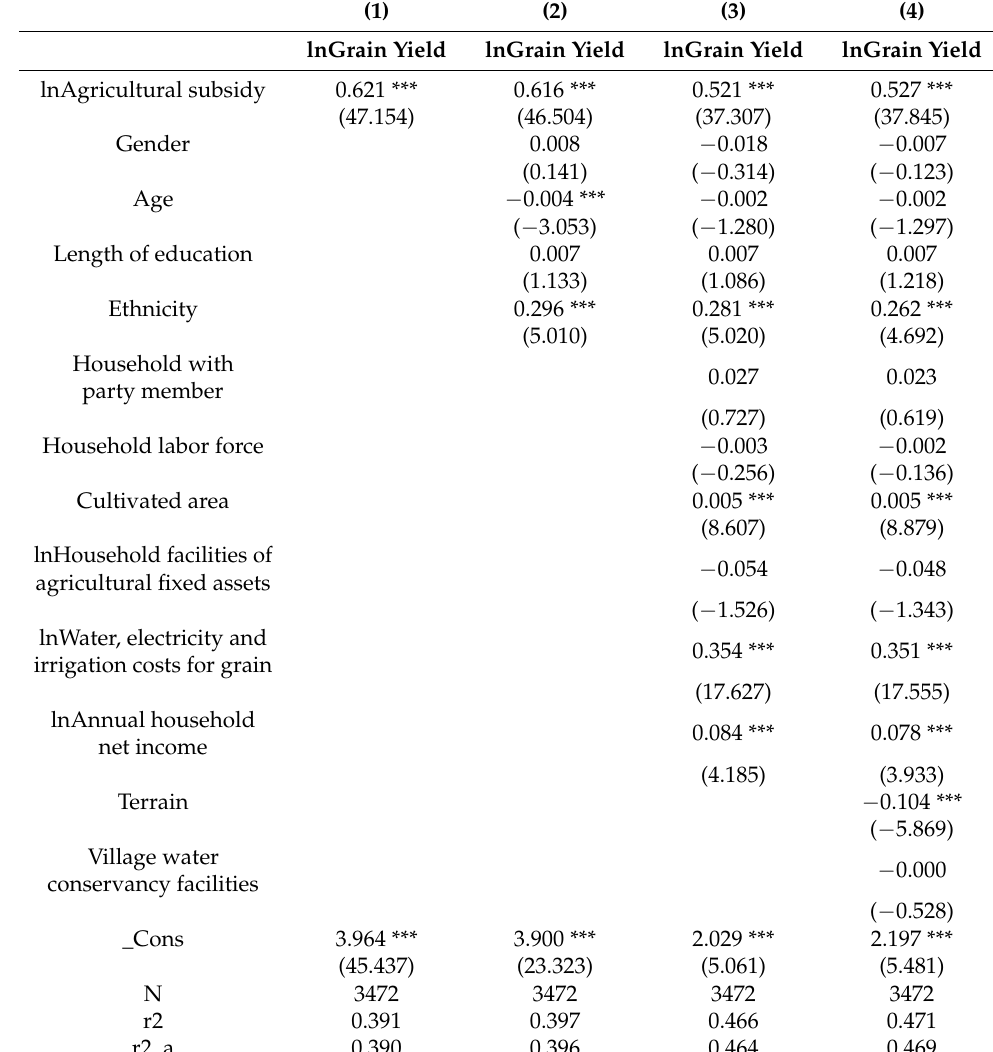
Table 2. Estimated results of the impact of agricultural subsidies on food